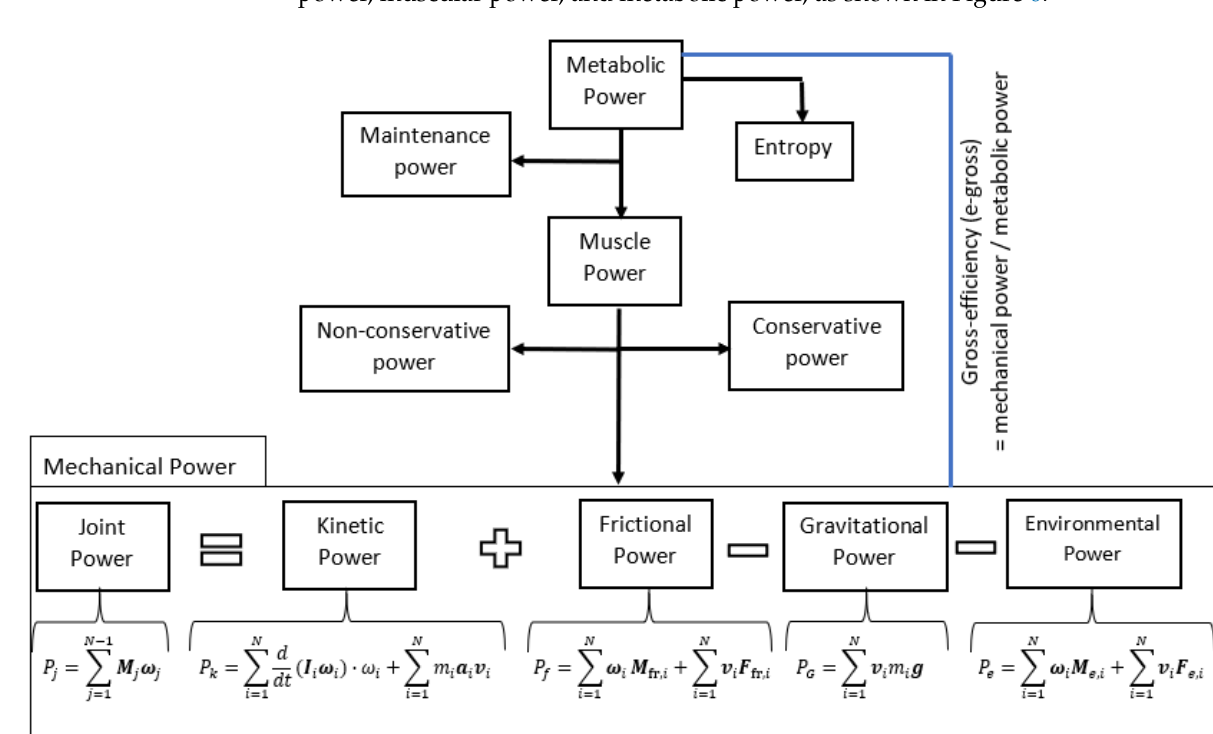
Figure 6. Power flow in human movement.